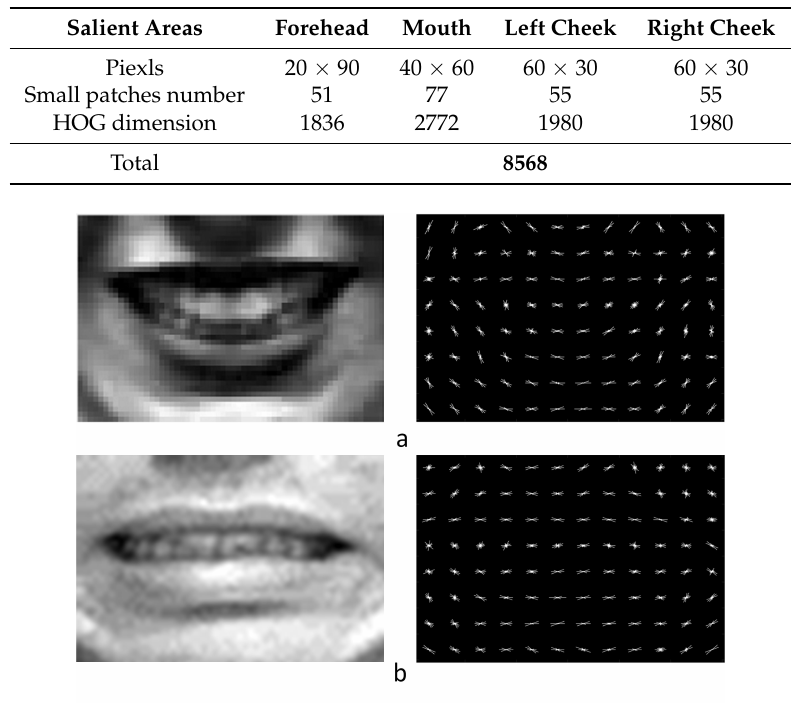
Table 2. Patches numbers and Histogram of Oriented Gradient (HOG) dimensions of salient areas.